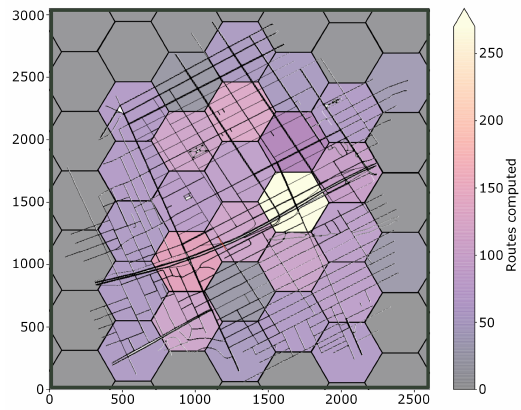
Figure 15. Routes computed per region-Ottawa Scenario.